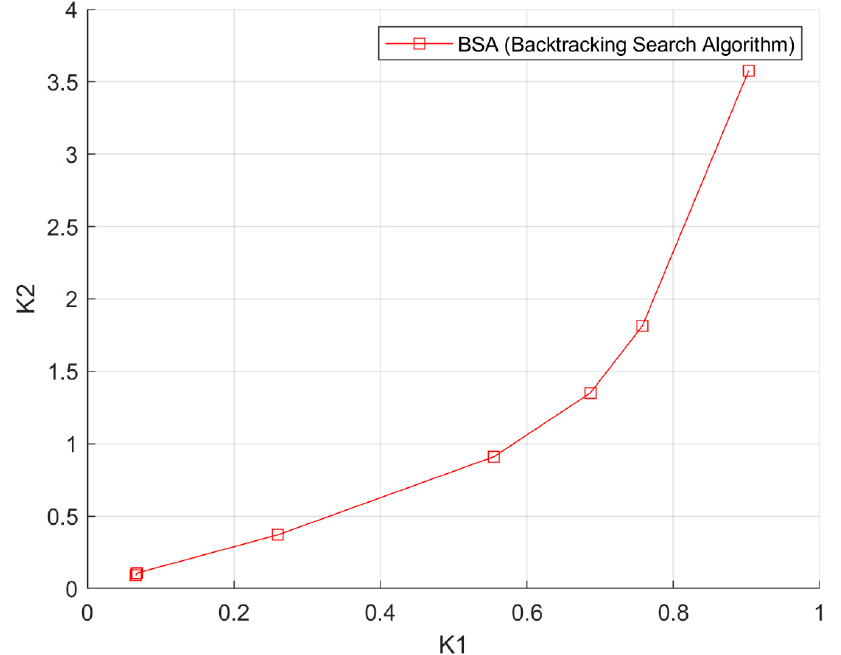
Figure 4. Pareto-optimal set for solving a problem by a method using a backtracking search algorithm.